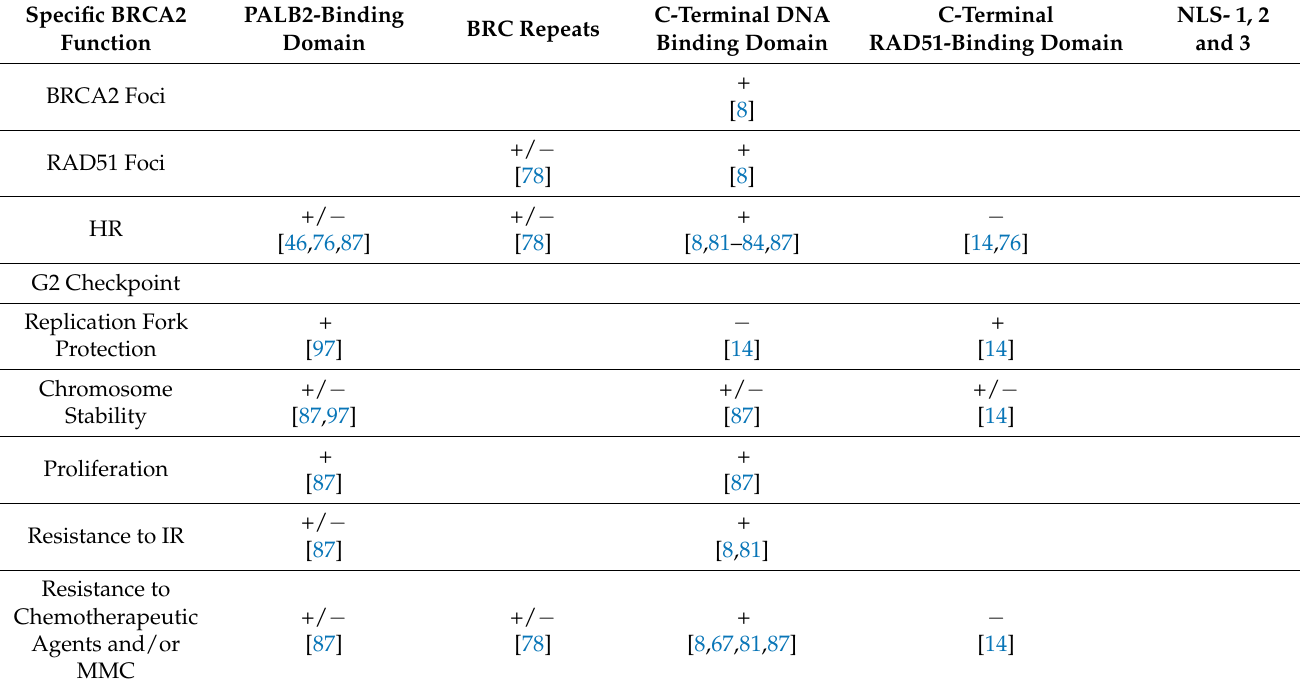
Table 2. Roles of domains with known cellular functions in mediating specific BRCA2 functions in DNA damage responses. Specific